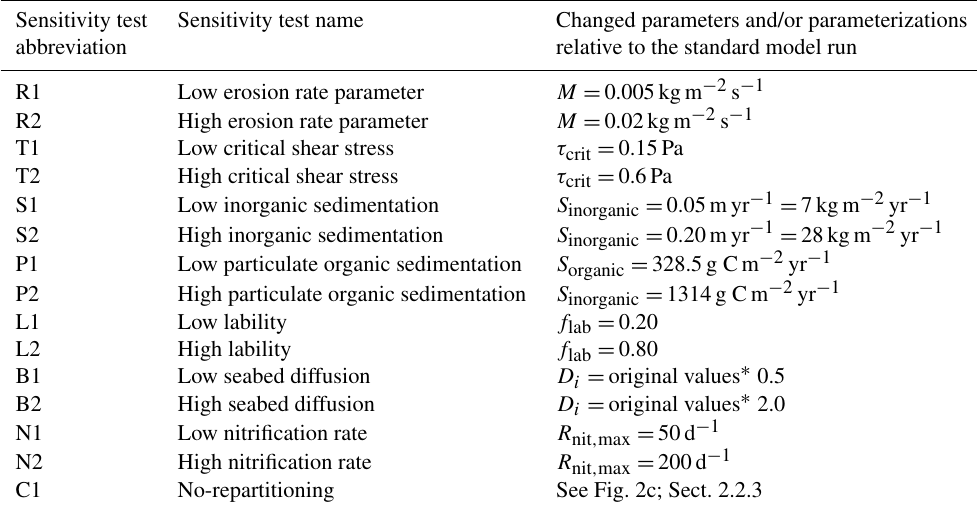
Table 4. List of sensitivity tests. Additionally, for each simulation listed here, an identical model run was completed that neglected resuspen- sion (i.e., with M = 0kgm − 2 s − 1 ; τ crit = 10Pa).